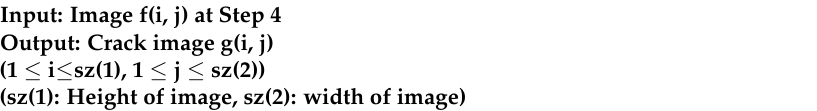
Table 9. User algorithm for crack